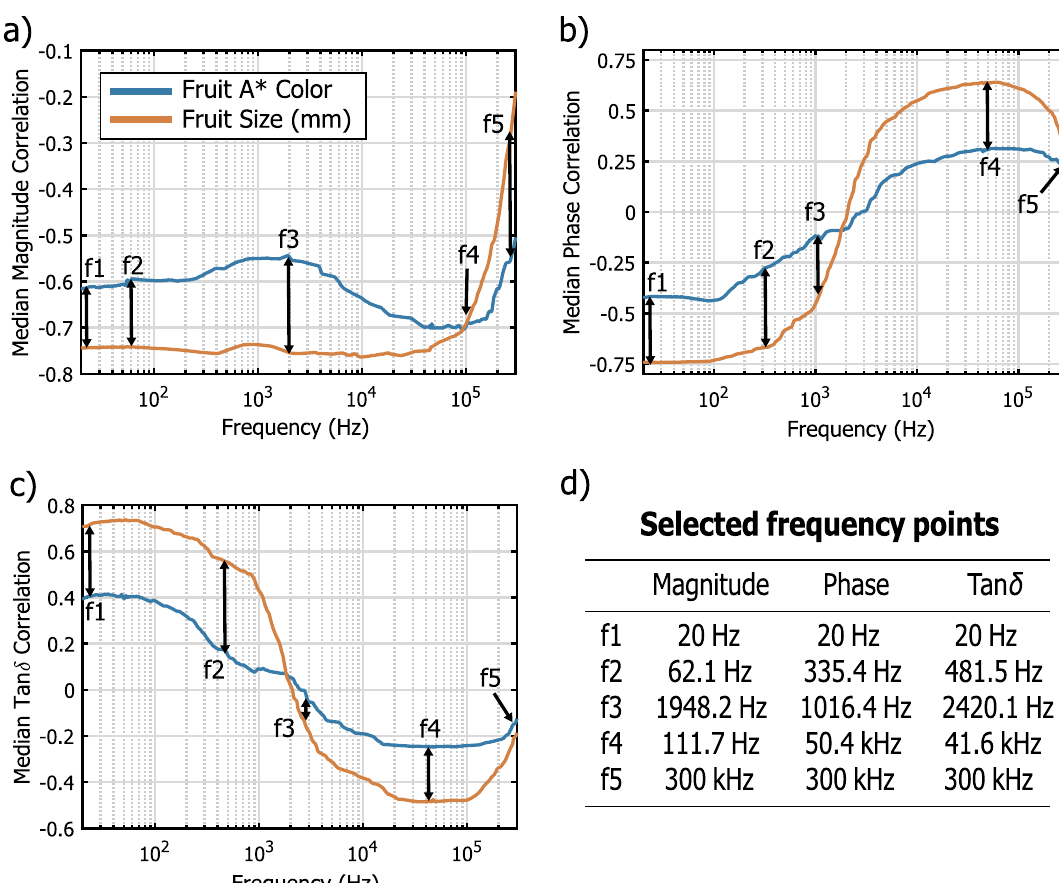
Figure 3. Median correlation of the fruit color (blue line) and size (red line) with the bioimpedance magnitude ( a ), phase ( b ) and tan δ ( c ) parameters, together with the 5 selected frequency points for each parameter ( d